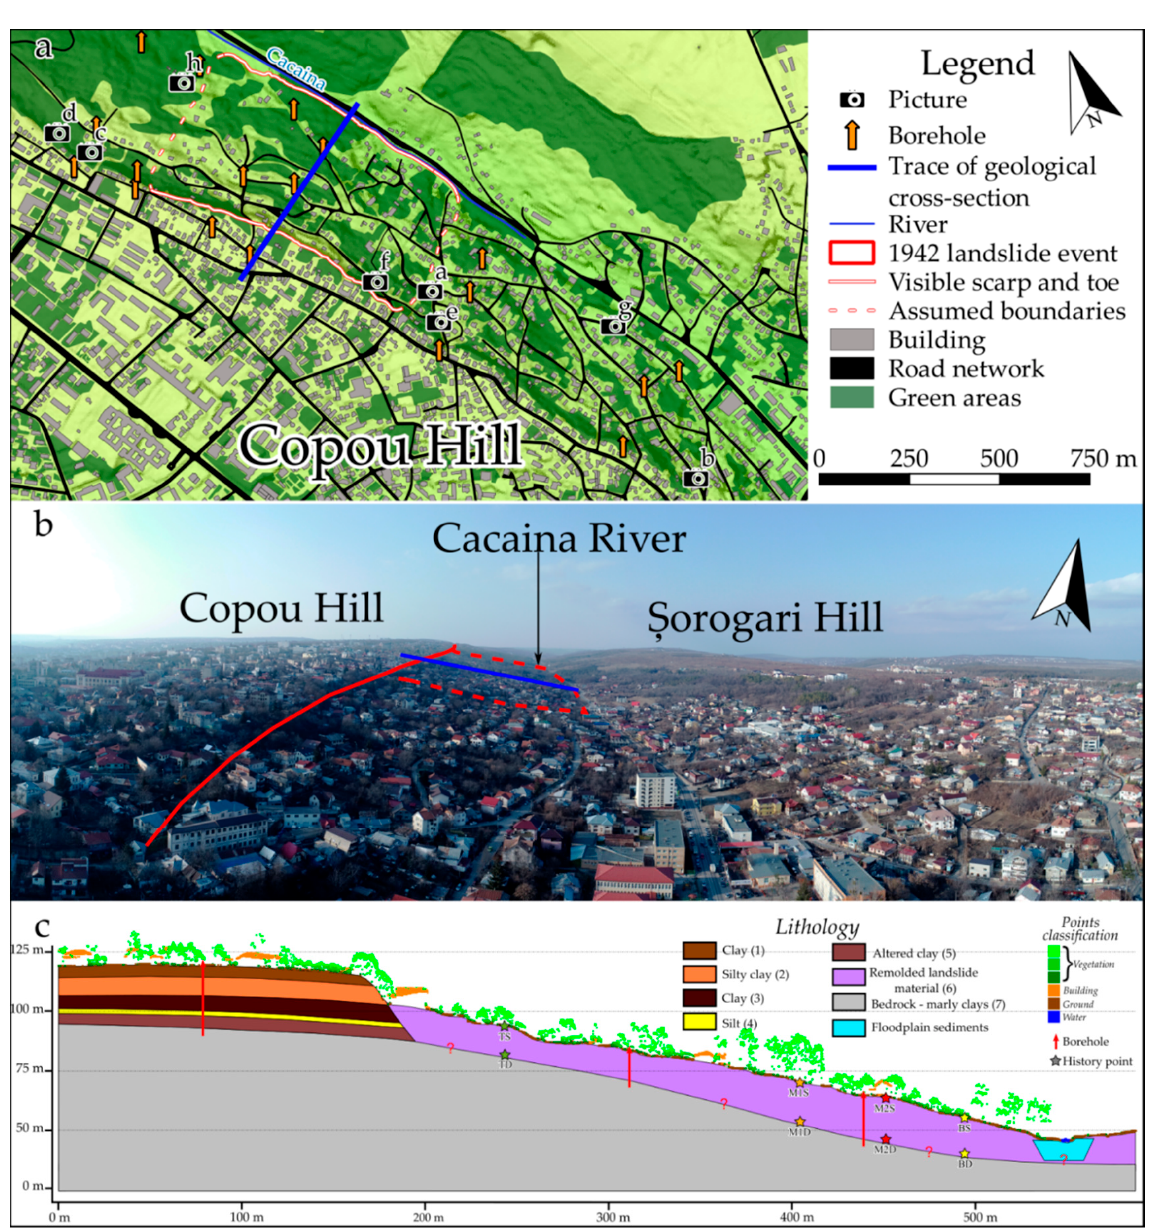
Figure 3. Ț ic ă u landslide location within Ia ș i Municipality. ( a ) Detailed view of the landslide. Solid red lines are the scarp and toe of landslide, according to [78]. Dashed red lines are the approximate boundaries of the 1942 event, according to the same source. The photos are in Figure 4. ( b ) Aerial photography of Ț ic ă u neighborhood. The solid red line represents the scarp affected by multiple reactivation events in the past. The red dashed line describes the location of the sector investigated in this study. The blue line represents the trace of the geological cross-section over the landslide. ( c ) The lithological section for the Ț ic ă u landslide. The question marks are placed because of the uncertainty between the displaced material and the bedrock. (high-resolution image available at https://doi.org/10.6084/m9.figshare.14915220.v1).